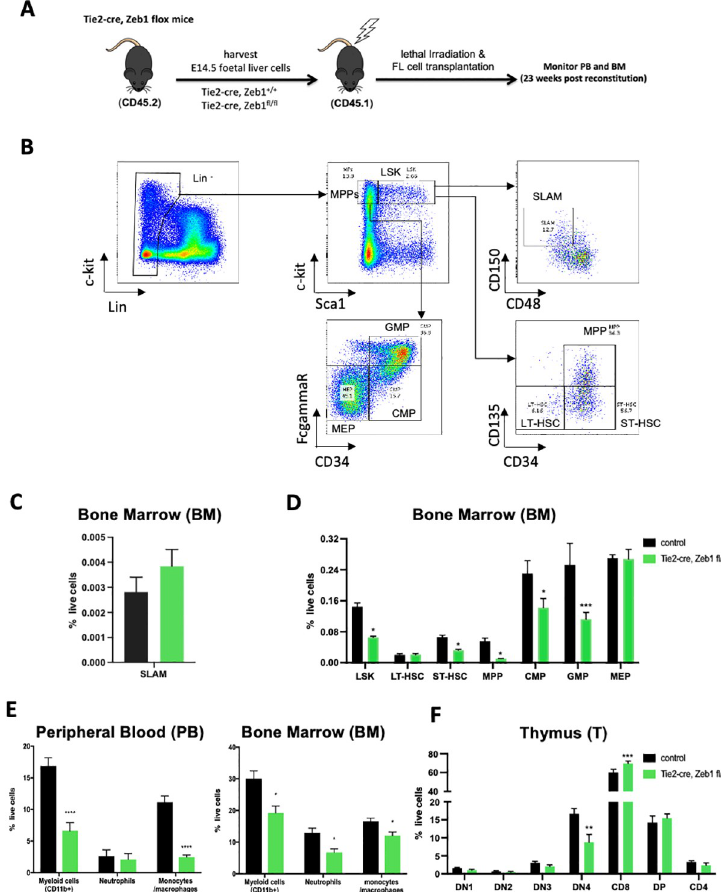
Fig 2. Hematopoietic-specific loss of Zeb1 leads to differentiation defects in specific HSPC populations as well as myeloid lineage and T-cell defects. (A) Schematic of BM transplant experiments using Zeb1 null CD45.2 + fetal liver HSPCs from Tie2-Cre, Zeb1 fl/fl mice, and Cre only controls transplanted into CD45.1 + recipients with PB and BM analysis conducted at 23 weeks post-transplant. (B) Overview of flow cytometry gating strategy used to analyze hematopoietic stem and progenitor (HSPC) populations. LSK cells were analyzed for SLAM marker expression (CD150, CD48) or were analyzed by parallel (CD135/CD34) marker expression to define MPP as well as ST and LT HSC populations more accurately. MPPs were analyzed by FcgammaR, CD34 expression to further define MEP, GMP, and CMP populations. (C) SLAM marker expression showing similar percentage of LT-HSCs (CD150 + CD48 − ) in Zeb1 null and control BM. (D) Overall, there were decreases in the percentage of Lin − Sca + cKit + cells likely composed of significant decreases in the percentage Zeb1 -deficient BM percentages for ST-HSCs and MPPs. Moreover, there were significant decreases in the percentage of as CMP and GMP cell populations in the BM of Zeb1 null reconstituted recipients. (E) Flow cytometric analysis of PB (left panel), BM of reconstituted mice showed defects in Zeb1 null HSPC contribution to myeloid cells (Cd11b + ) including monocytic (Cd11b + Ly6G) and NEU (Cd11b + Ly6G + ) lineage cells. (F) Cytometric analysis of thymic T-cell populations showed significantly decreased percentage of CD25 − CD44 − DN4 progenitors and increased CD8 + mature T cells. Error bars indicate SD of the mean ( n = 4 per group, � p < 0.05, �� p < 0.01, ���� p < 0.0001, nonparametric t test). Raw data behind graphs are included in A in S1 Data. BM, bone marrow; HSPC, hematopoietic stem and progenitor cell; LSK, Lin − Sca1 + cKit + ; LT-HSC, long-term HSC; MPP, multipotent progenitor; NEU, neutrophil; PB, peripheral blood; ST-HSC, short-term HSC. fetal livers of Vav-iCre; Zeb1 fl/fl embryos as well as Cre-negative controls. We have previously demonstrated that the Vav-iCre line is specific to the hematopoietic lineage at this stage, whereas the Tie2-Cre system is active in both the endothelium and hematopoietic system [8]. Here, we demonstrated decreased hematopoietic colony formation potential of Zeb1 -deficient HSPCs; in primary plating experiments there was a 50% reduction in myeloid lineage colony